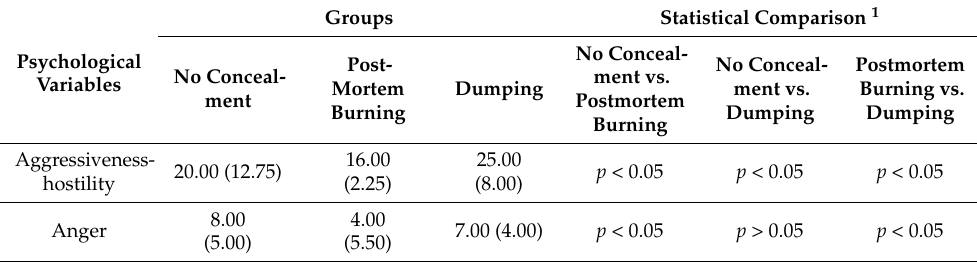
Table 5. Comparison of median of aggressiveness-hostility and anger among participants that committed dumping and post-mortem burning as murder concealment acts, as well as those who did not commit murder